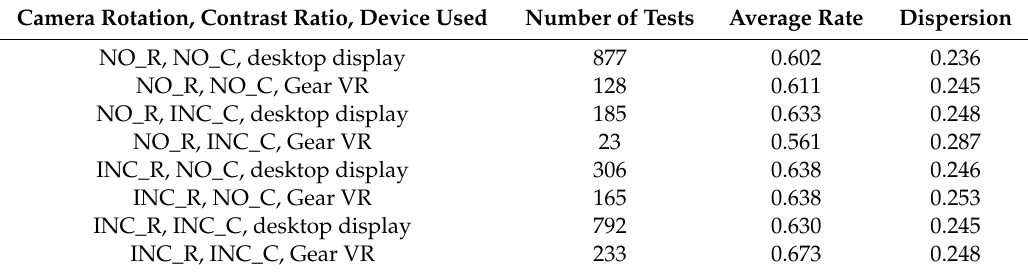
Table A18. Numerical results of the users regarding the camera rotation, contrast ratio and device used. Camera Rotation, Contrast Ratio, Device